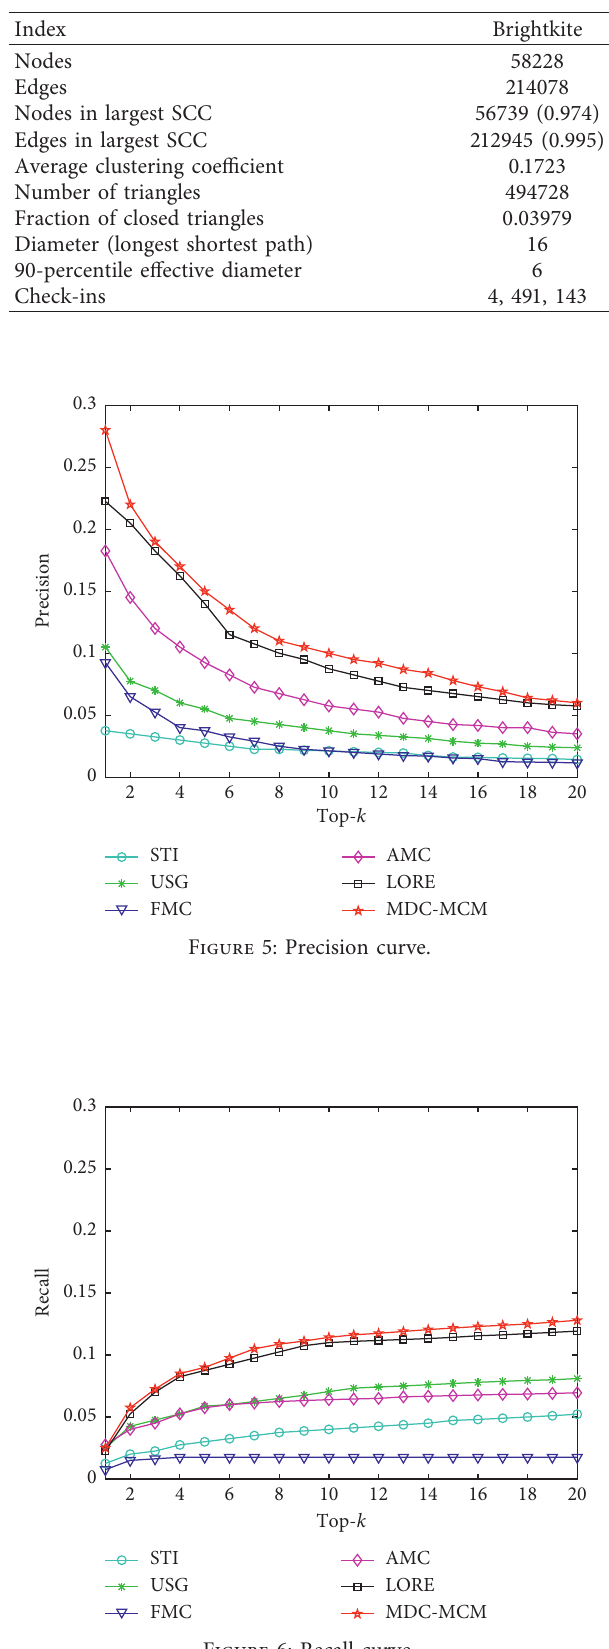
Figure 6: Recall